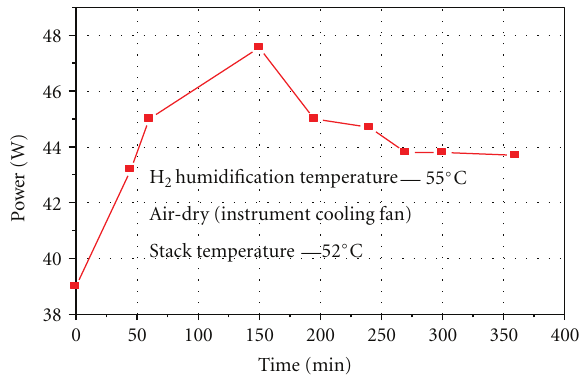
Figure 6: Stability of the stack performance.